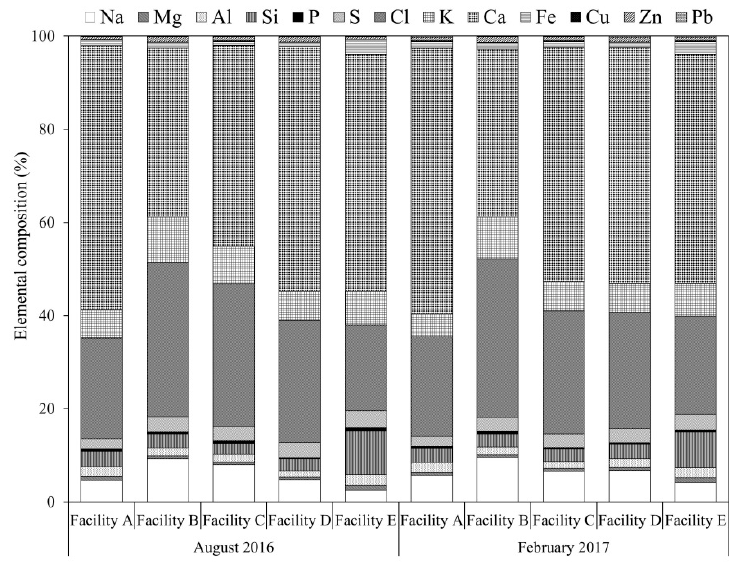
Figure 2. Elemental composition of fly ash (FA) determined using energy dispersive X-ray fluorescence spectroscopy.